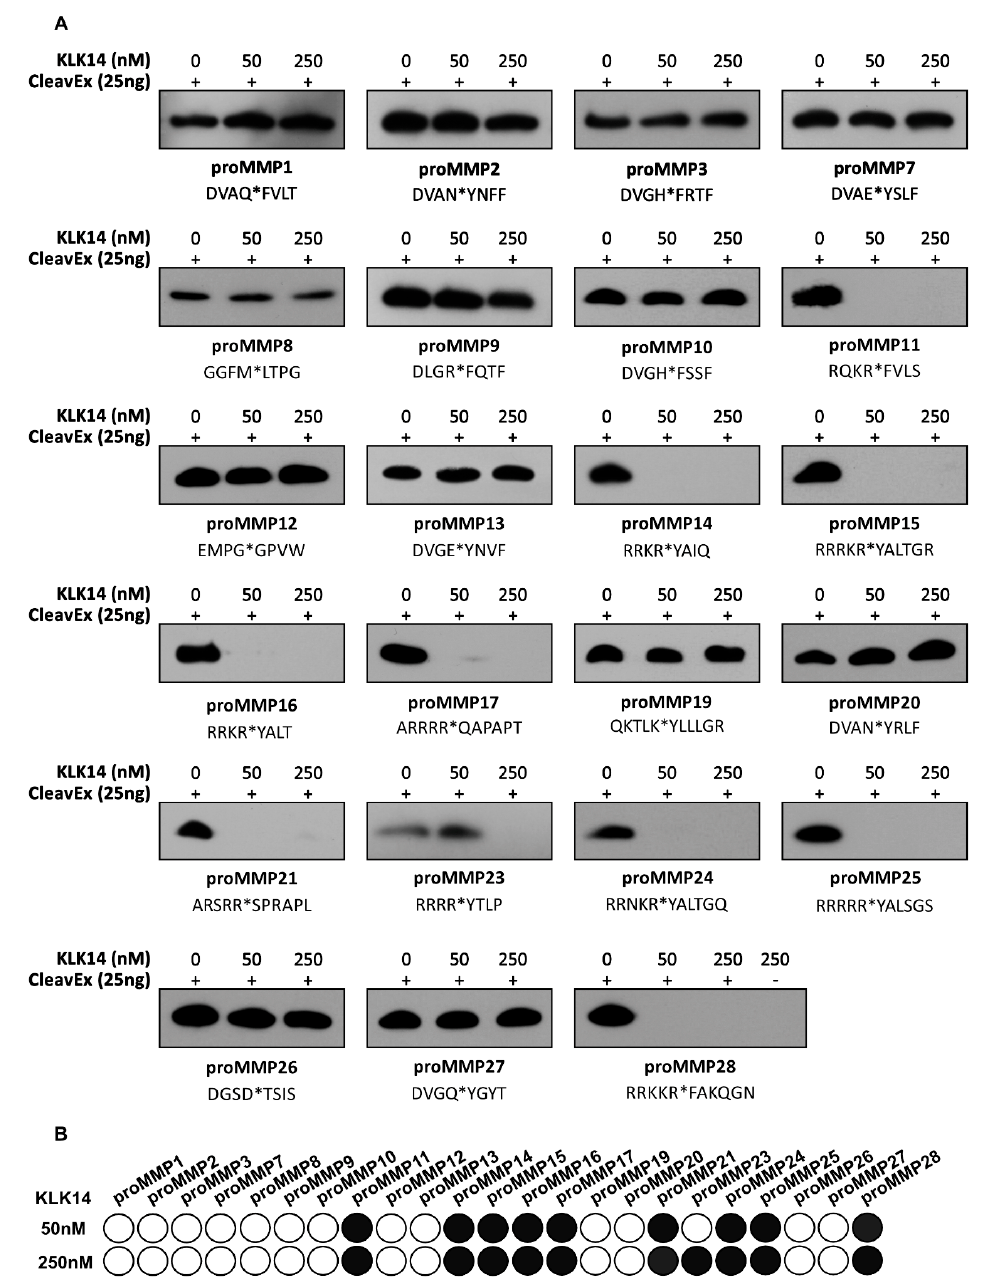
Figure 1. Effect of KLK14 on the CleavEx proMMP fusion proteins. ( A ) Western blot analysis of each 25 ng CleavEx proMMP protein incubated with 50 and 250 nM KLK14 after 1 h at 37 °C. Each fusion protein with its respective activation sequence is listed with the native site of hydrolysis indicated by an asterisk. ( B ) Schematic representation of the CleavEx proMMP fusion proteins from the Western blots in panel A. Scoring was performed by densitometry analysis using ImageJ. The shading is based on the quartile of change: 100–75% of control sample intensity is presented as white (no degradation); 75–50% as light grey; 50–25% as dark grey; and 25% and lower as black. KLK = kallikrein-related peptidase; CleavEx = Cleav age of ex posed amino acid sequences; MMP = matrix metalloproteinase.